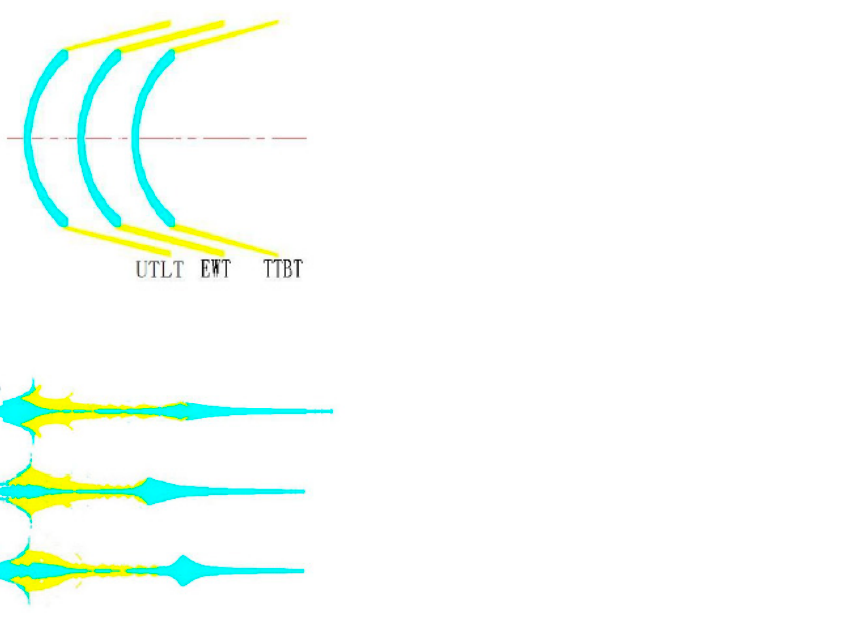
Figure 14. Jets formed by different truncated cones at the same time. ( a ) SCS liner with different truncated cones; ( b ) jet formed by SCS liner with different truncated cones.